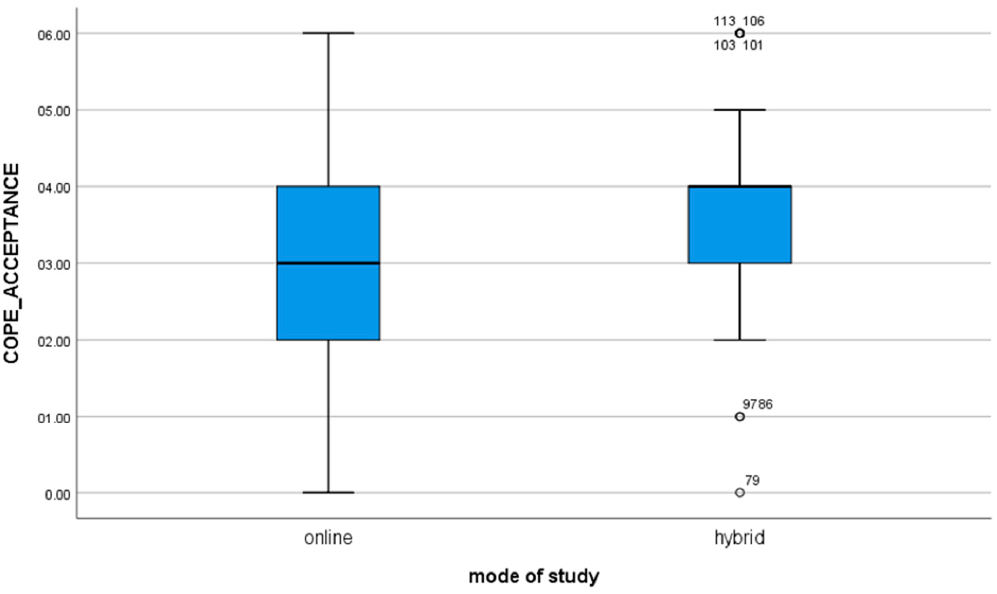
Figure 3. For the variable